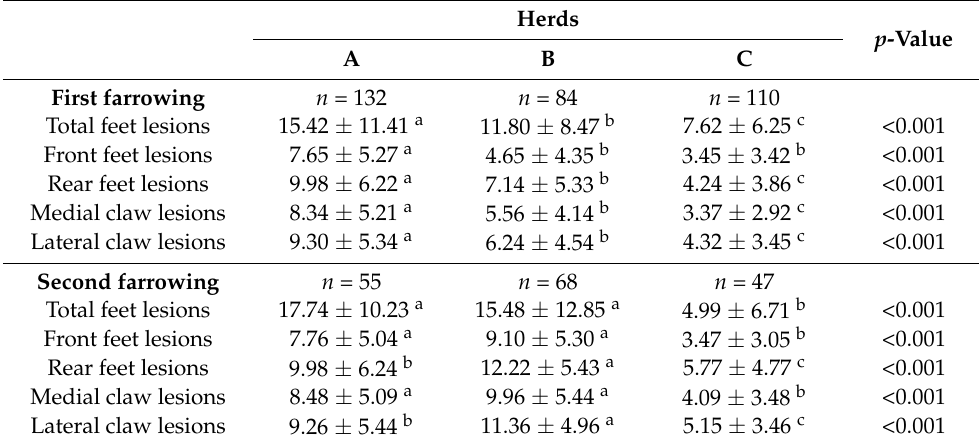
Table 6. Results of claw lesions (mean ± SD) in replacement gilts of different genetic lines in three farrow-to-finish herds in Greece, at first and second farrowing. Herds p -Value A B C First farrowing n =